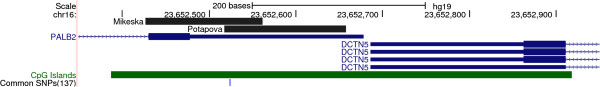
Genomic positions of the PCR amplicons used in the Potapova study and in this study respectively, relative to exon 1 of PALB2 in the UCSC Genome Browser (GRCh37/hg19). The region investigated in this study partially overlaps with the region analysed in the Potapova study [9].